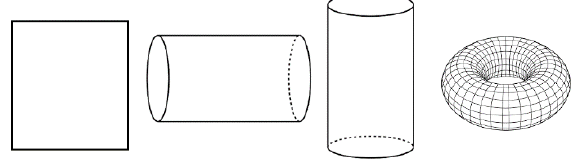
Figure 2. The world types of NetLogo: box, horizontal cylinder, vertical cylinder, torus